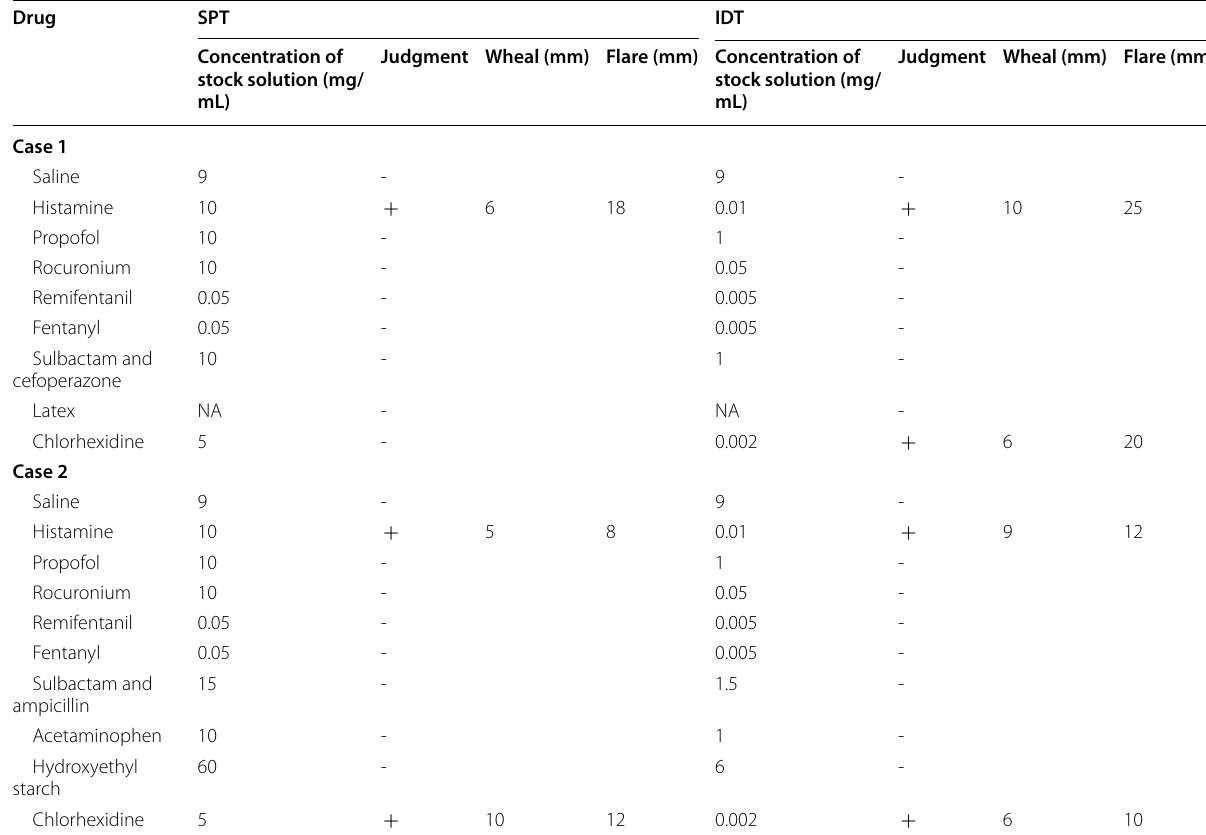
Table 1 Results of skin